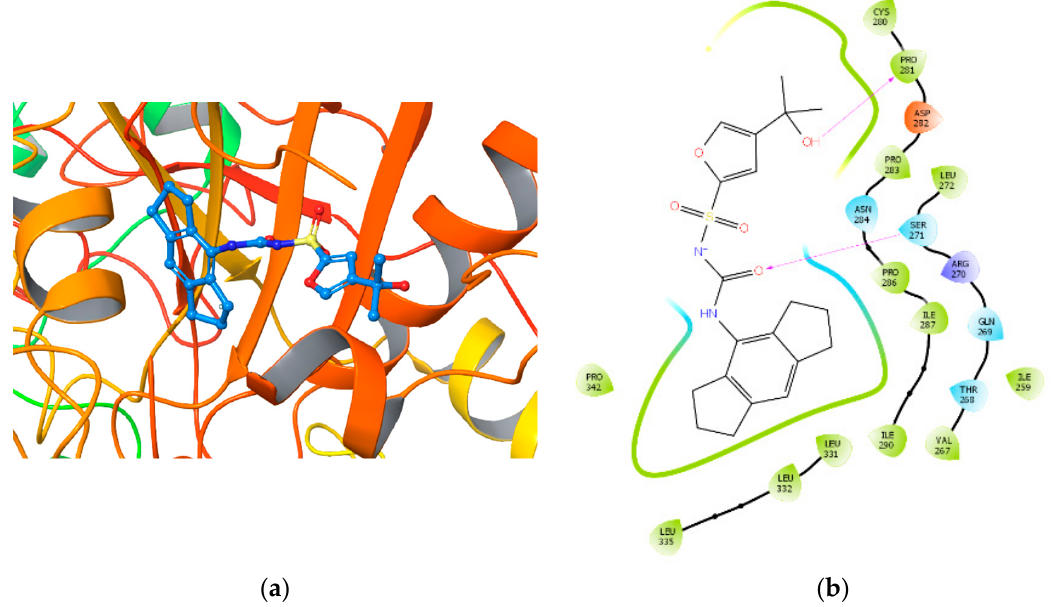
Figure 2. ( a ) The MCC950 binding pose from the extra precision (XP) docking experiment; ( b ) ligand interaction diagram of the MCC950 binding pose. Purple arrows refer to H-bond interactions, green lines around molecule underline non-polar regions whereas the blue ones point polar residues.